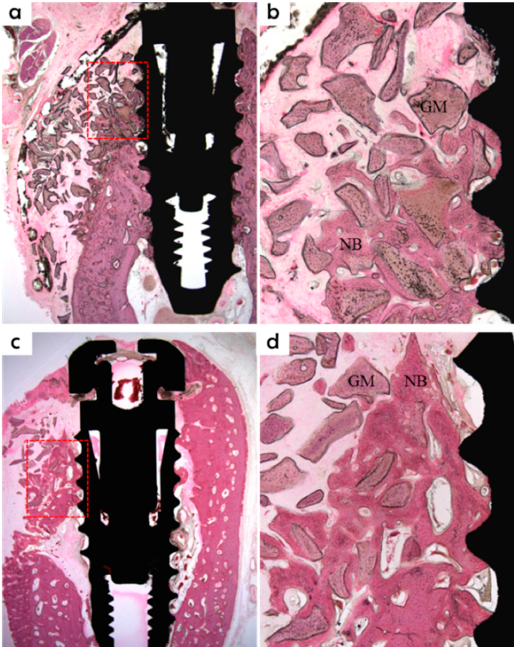
Figure 12. Histological sections of the PCL/PLGA/ β -TCP group at week 8 after surgery. A significant amount of new bone formation was found. GM, bone grafting material; NB, new bone. (H&E stain; original magnification 12.5× ( a ) and ( c ); 40× ( b ) and ( d )). Red box in ( a ) is the area of ( b ), red box in ( c ) is the area of ( d ).